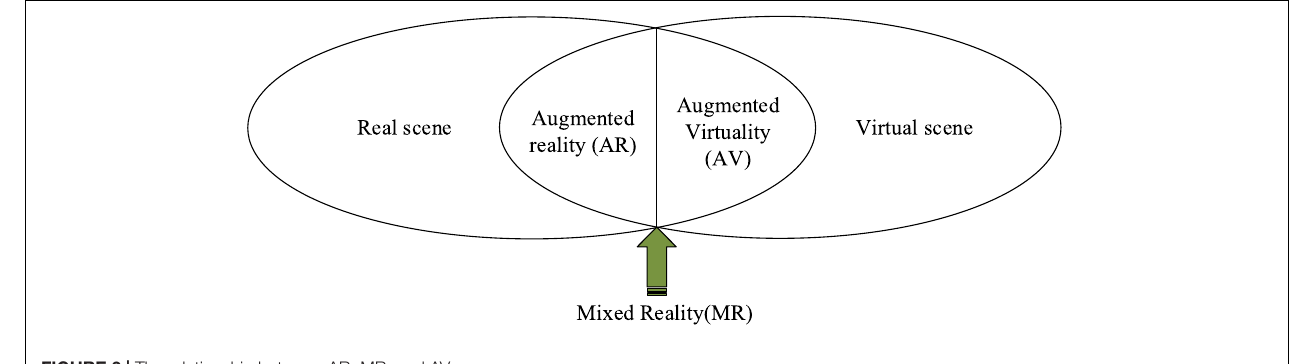
FIGURE 3 | The relationship between AR, MR, and AV.